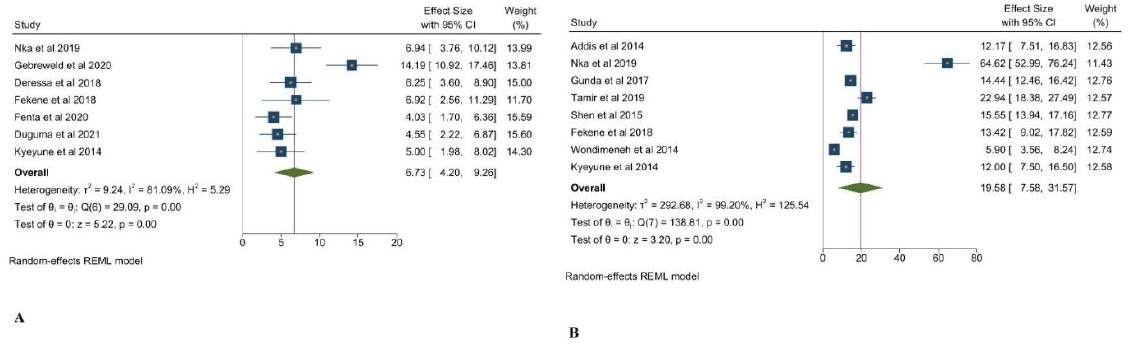
Figure 6. Pooled prevalence of thrombocytopenia in HAART subject ( A ), HAART naïve ( B ) [1,18 – 28].